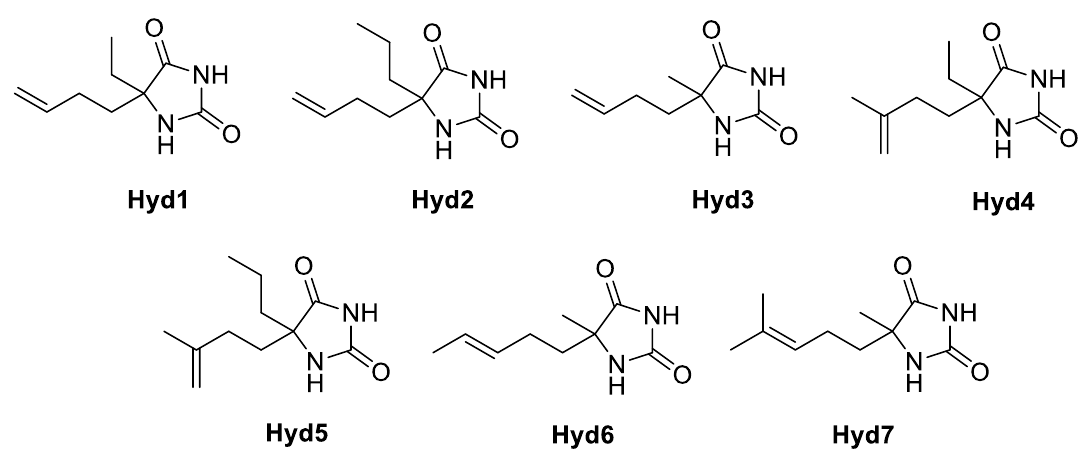
Figure 1. 5-Alkenyl hydantoin derivatives.